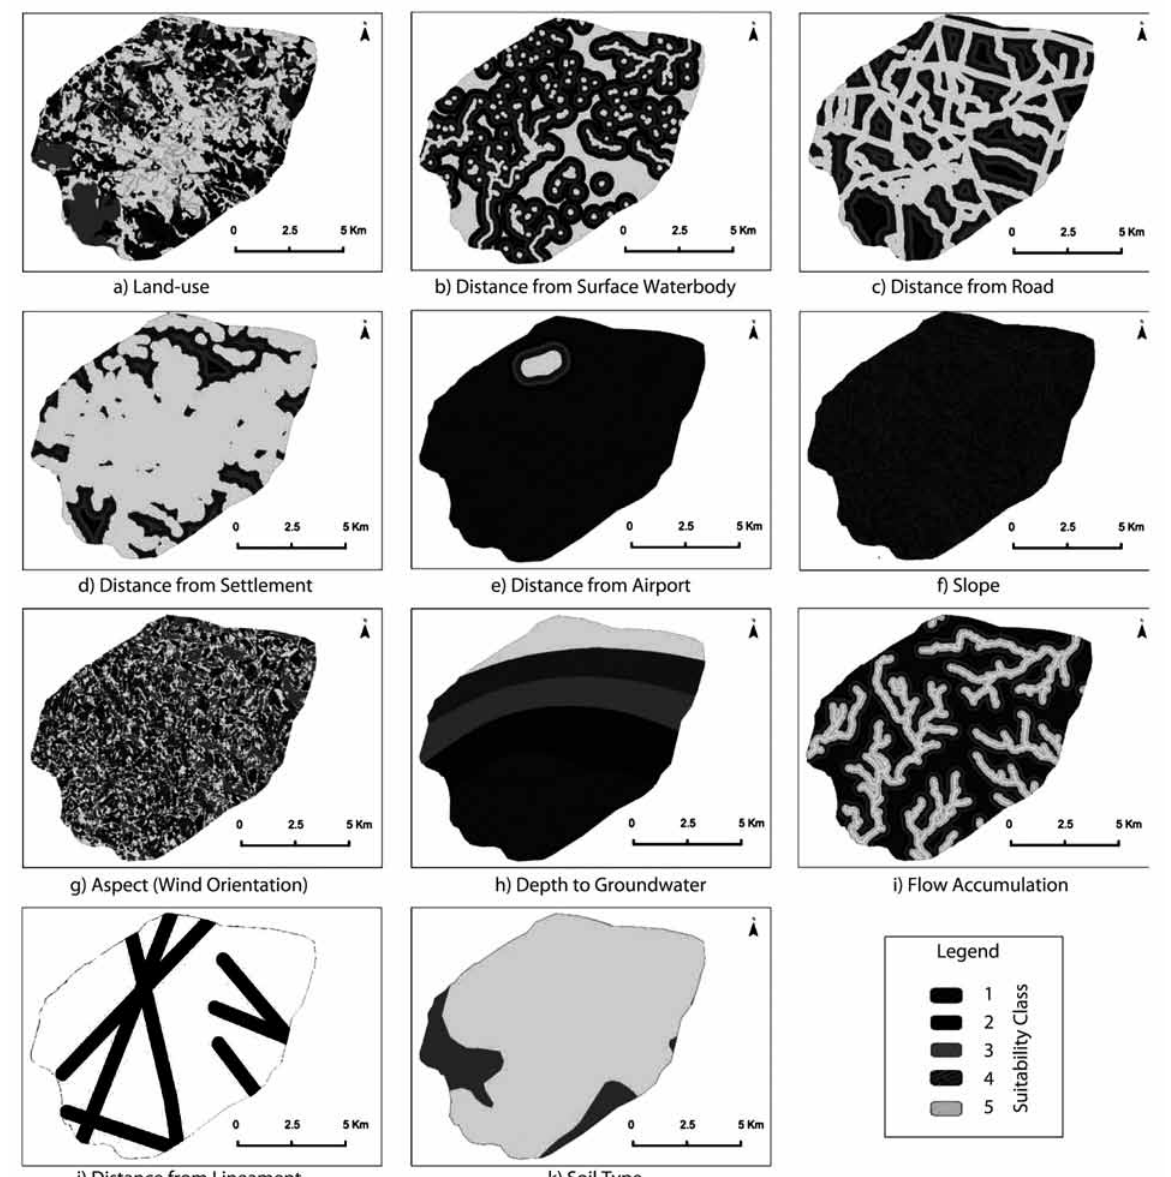
Fig. 4. Suitability map of all the selected